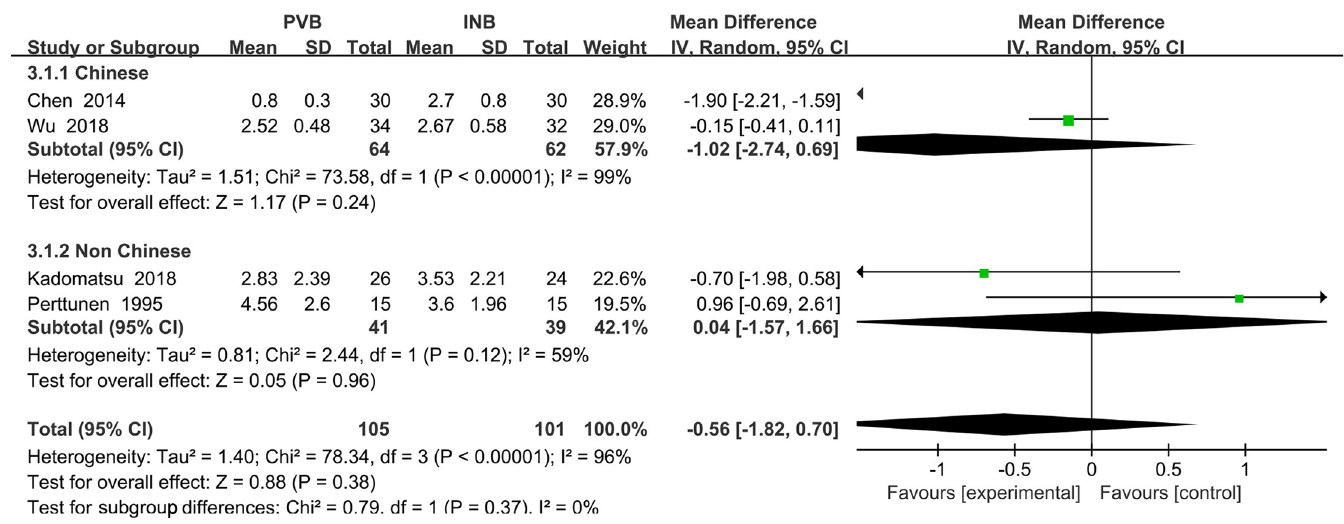
Fig 7. Subgroup analysis of comparison: Chinese VS non Chinese. Outcome: VAS at rest at the first 2 h.